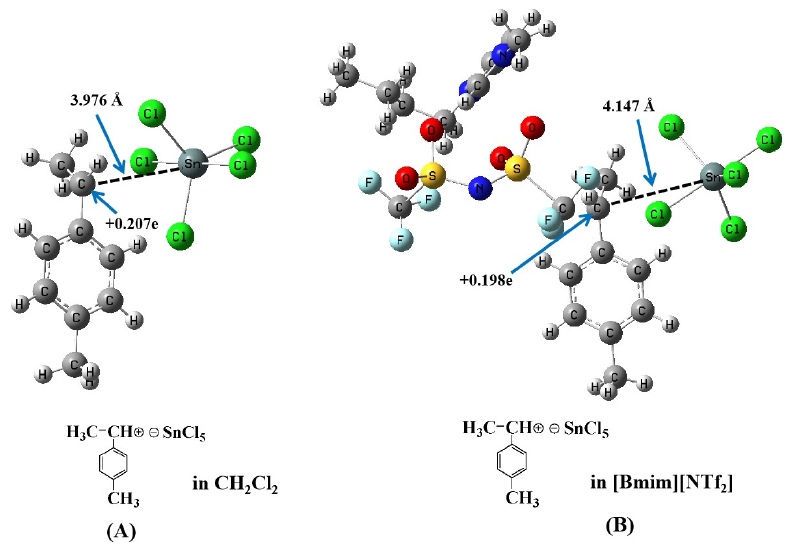
Figure 3. Optimized structures of p -MeSt + ··· SnCl 5 − in ( A ) CH 2 Cl 2 and ( B ) [Bmim][NTF 2 ], calculated by DFT at the B3LYP/3-21G level.